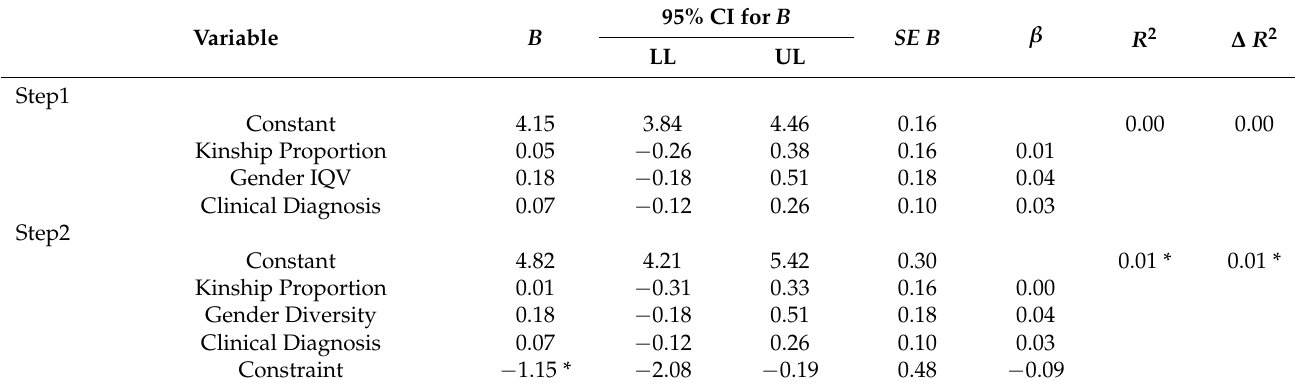
Table 6. Hierarchical linear regression results for depression mitigation behaviors: evaluating the role of